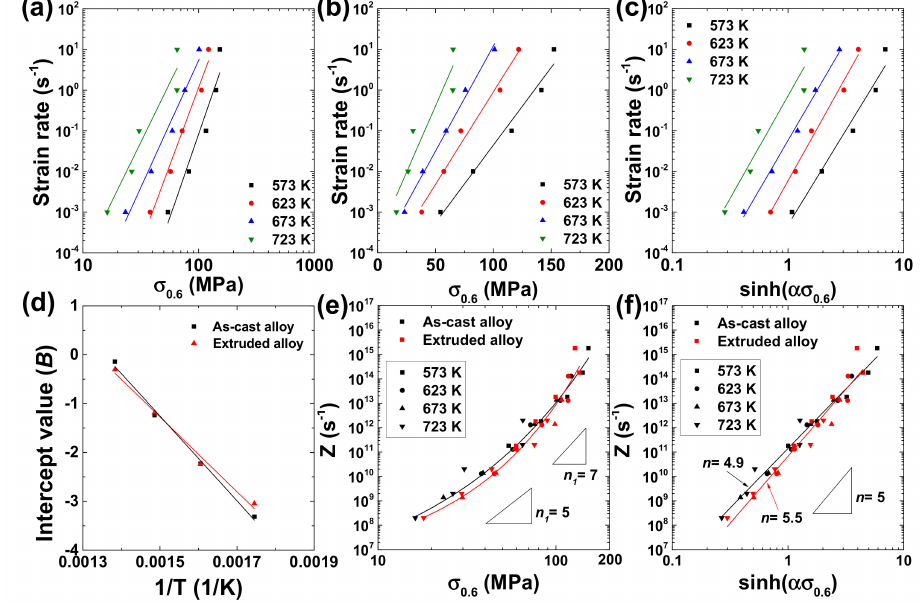
. ε − . ε − σ . ε − Figure 4. The plots of ( a ) log log σ , ( b ) log and ( c ) log log ( sinh ( ασ )) for the as-cast alloy at ε = 0.6. ( d ) The plots of B – 1 / T for the determination of Q c for the as-cast and extruded alloys at ε = 0.6. The plots of ( e ) log Z − log σ and ( f ) log Z − log sinh ( ασ ) for the as-cast and extruded alloys at ε =